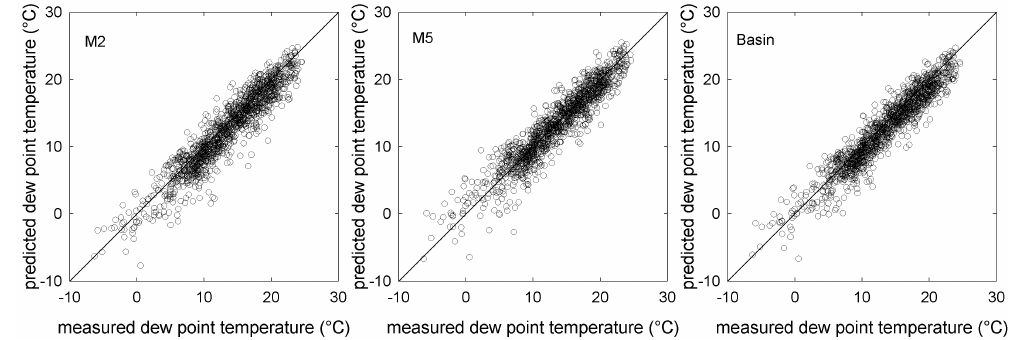
Fig. 11. Scatter plots of dew point temperature hourly data predicted by the model and measured by the buoy in the M2, M5 grid points and for the “average basin”